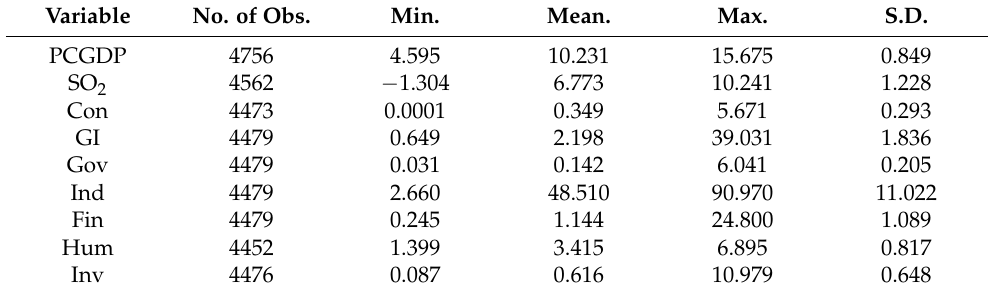
Table 1. Descriptive